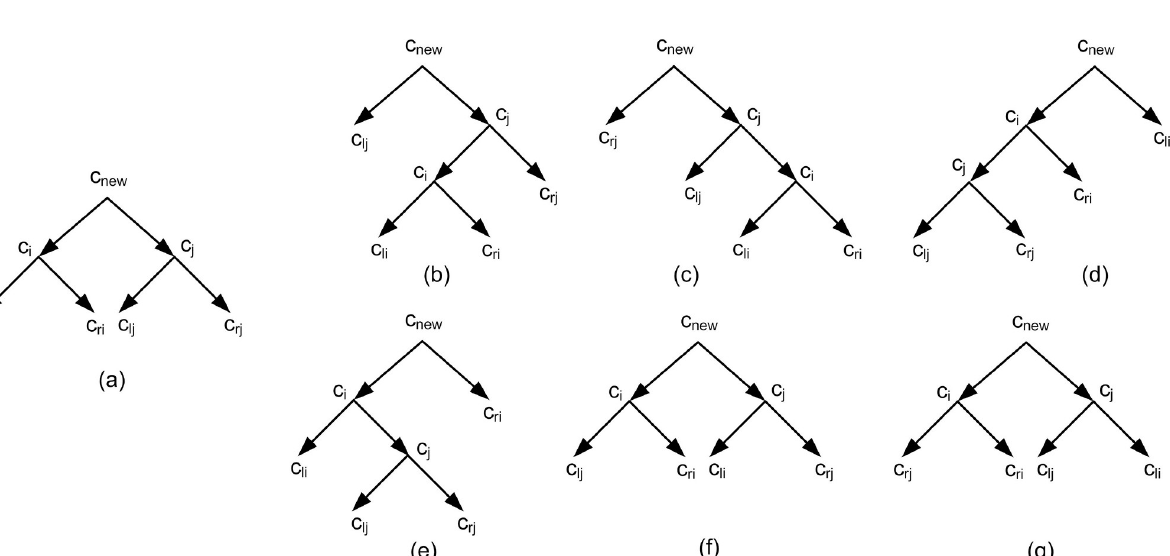
Ð c , c Ð c , c Ð c , c i lj i rj j li j